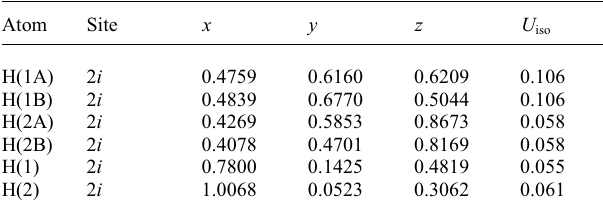
Table 2. Atomic coordinates and displacement parameters (in Å 2 )